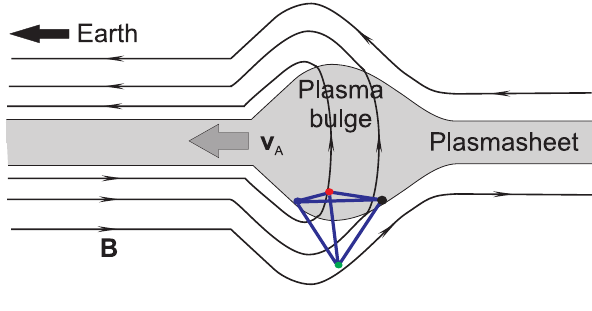
Fig. 5. Sketch for the situation as it appears during TCR2 and TCR3. The plasma bulge swaps over s/c C1, C2 and C4, whereas C3 remains outside the plasma sheet in the lobe region. Due to the different magnetic field lines configuration, the spacecraft inside the plasma bulge detect a decrease in B x and in the total magnetic field strength as well as an increase in B z